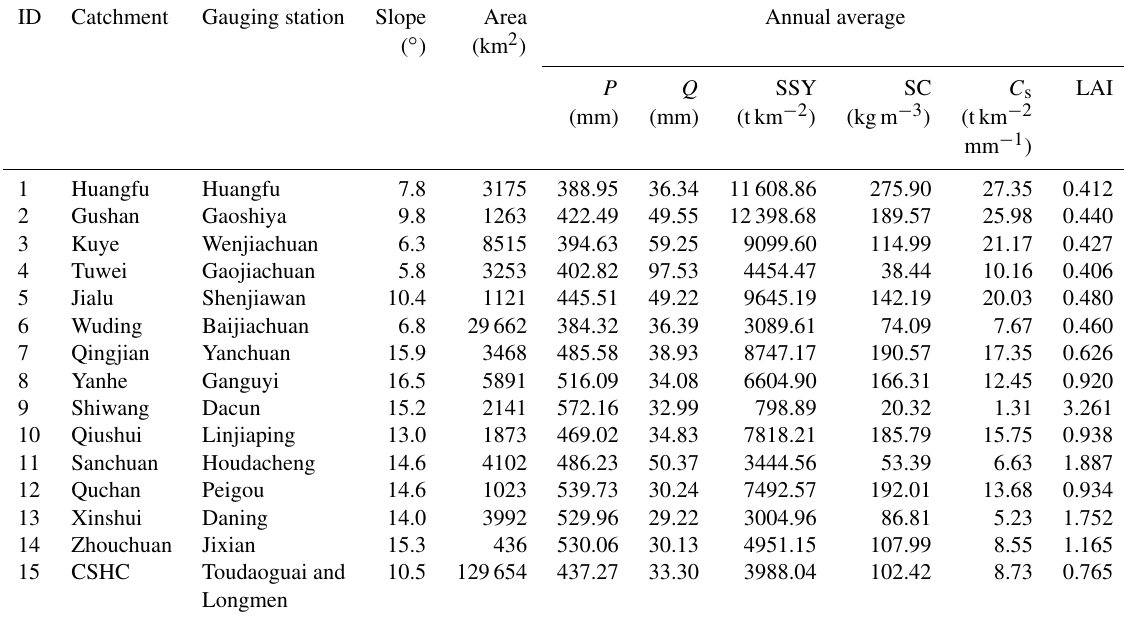
Table 1. Long-term hydrometeorological characteristics (1961–2011) and growing season leaf area index (LAI) (1982–2011) of the studied catchments in the Loess